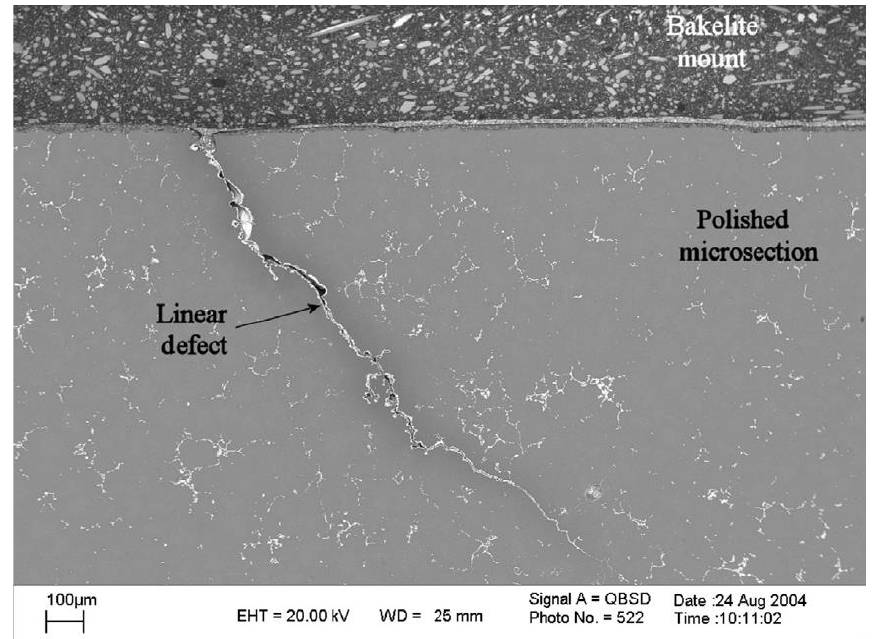
Figure 11. A bifilm crack over 1 mm long found adjacent to the cracked web on a cast Mg alloy housing Reprinted with permission from ref. [53]. Copyright 2022 Elsevier.